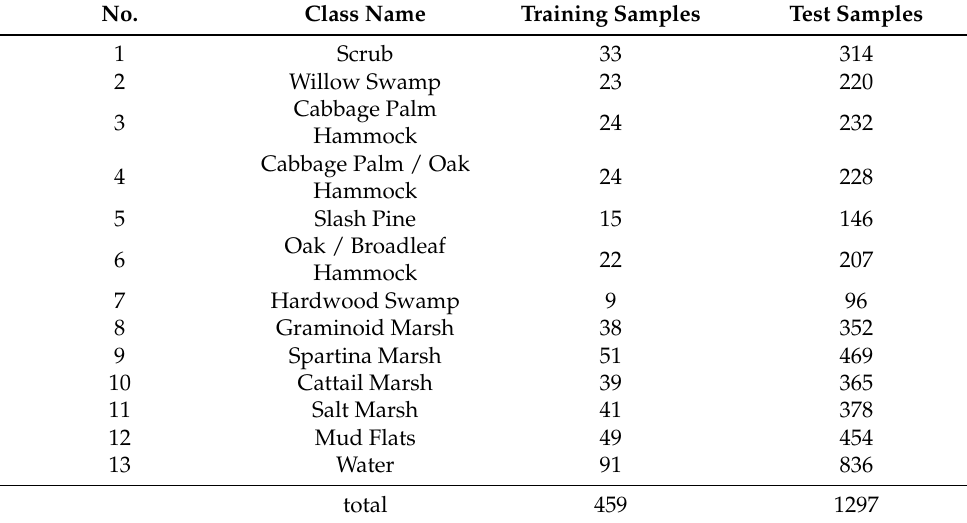
Table 3. Samples distribution for KSC